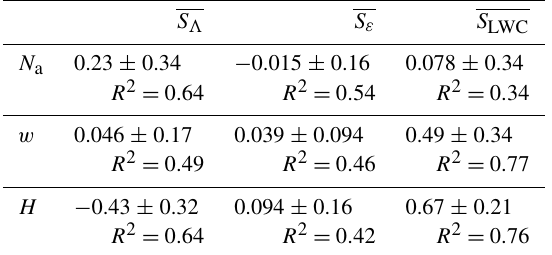
Table 4. Same as Table 3, but for the sensitivities in (cid:51) , ε , and LWC.